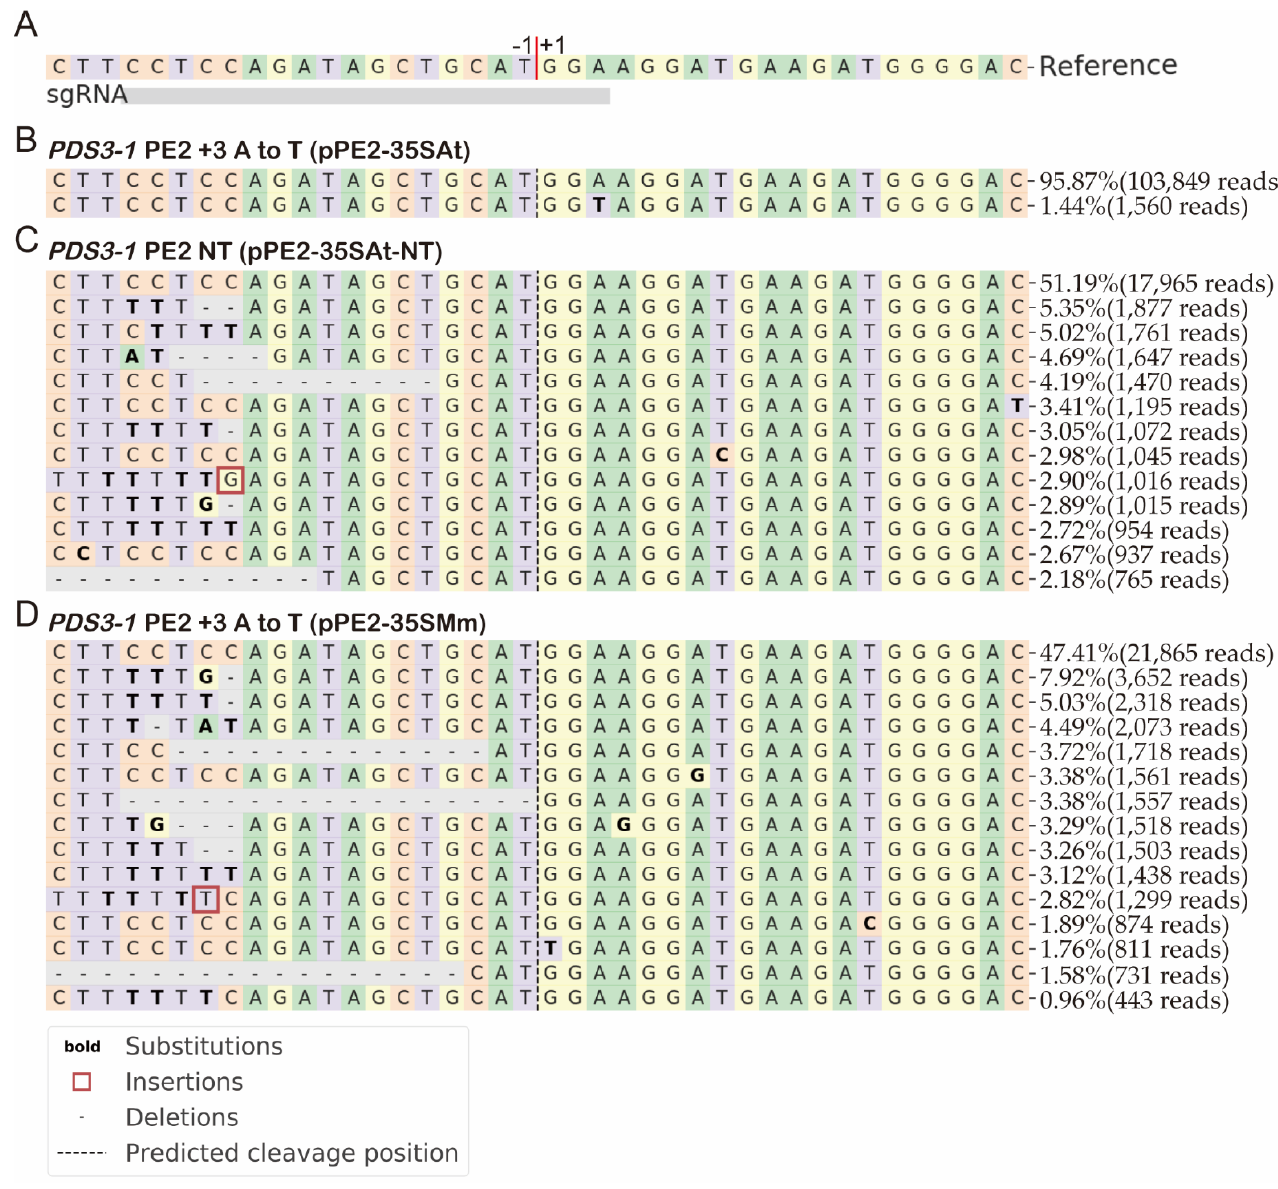
Figure 4. NGS analyzed data. Alleles of PDS3-1 site isolated from protoplasts of Arabidopsis after editing with pPE2-35SAt, pPE2-35SAt-NT, and pPE2-35SMm. The amplicons sequenced by an Illumina MiSeq for NGS were analyzed using CRISPResso2. ( A ) represents the wild-type reference sequence. ( B ) represents the successful PE2 via pPE2-35SAt. ( C ) represents control consisting of sgRNA and not pegRNA. ( D ) represents indels when pPE2-35SMm was used.